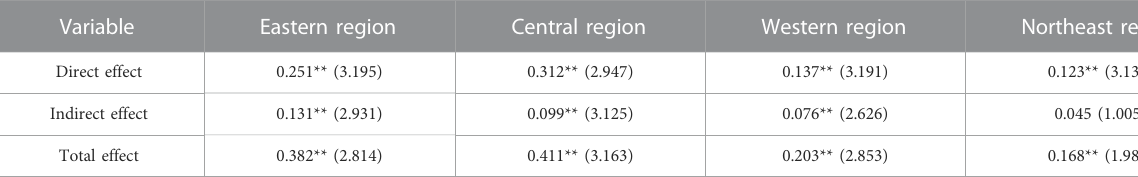
TABLE 11 Decomposition results of spatial effect in different regions.